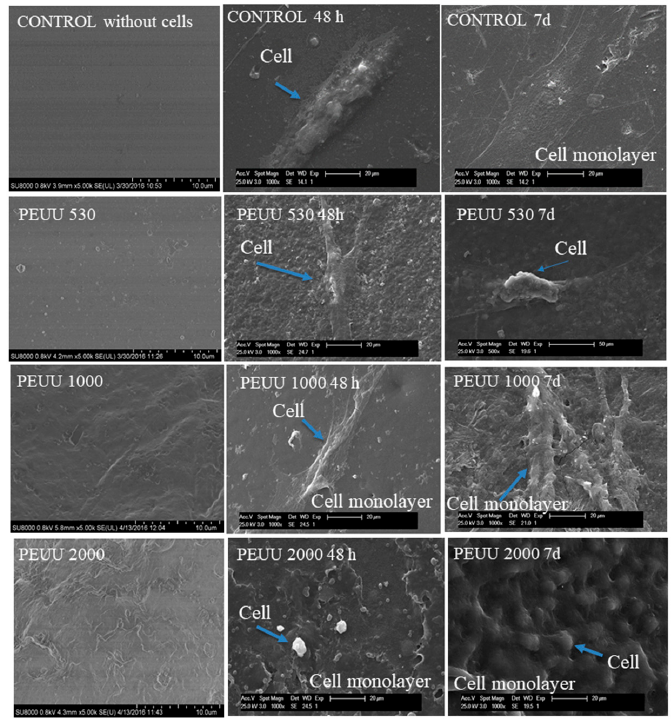
Figure 9. SEM of cell adhesion at 48 h and 7 days on the PEUUs.